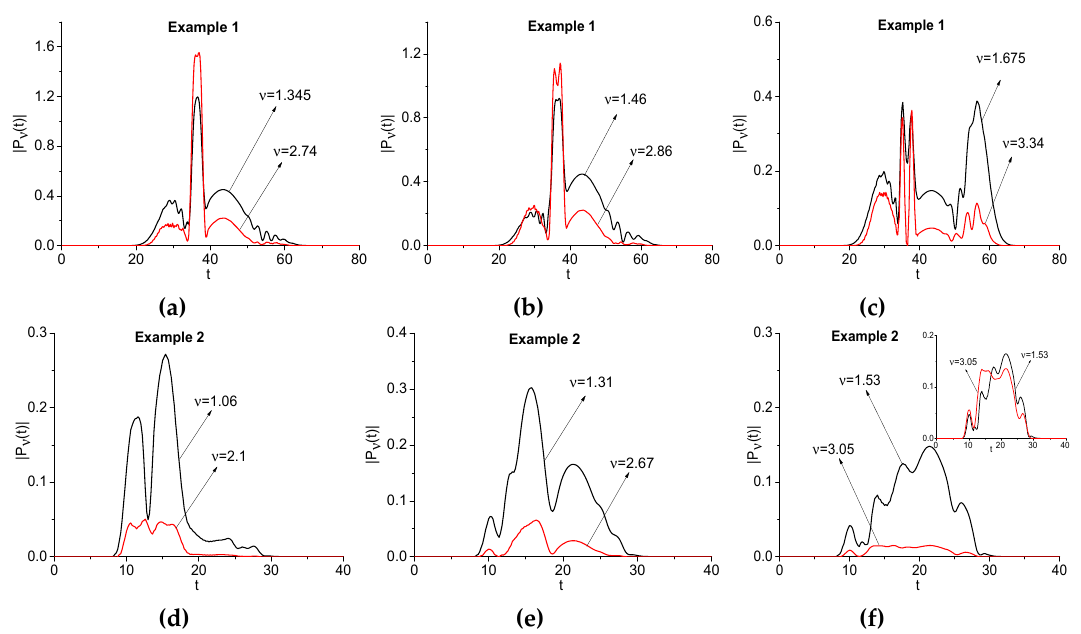
Figure 8. Evolution of the spectral amplitude modulus at the basic frequencies ν base = 1.345, 1.46, 1.675 (Example 1) and ν base = 1.06, 1.31, 1.53 (Example 2) (black lines, signal E inc ( t ) ) and at the frequencies close to doubled basic frequencies ν = 2.74, 2.86, 3.34 (Example 1) and ν = 2.1, 2.67, 3.05 (Example 2) (red lines, signal E inc 2 ( t ) ), respectively depicted in ( a – f ).